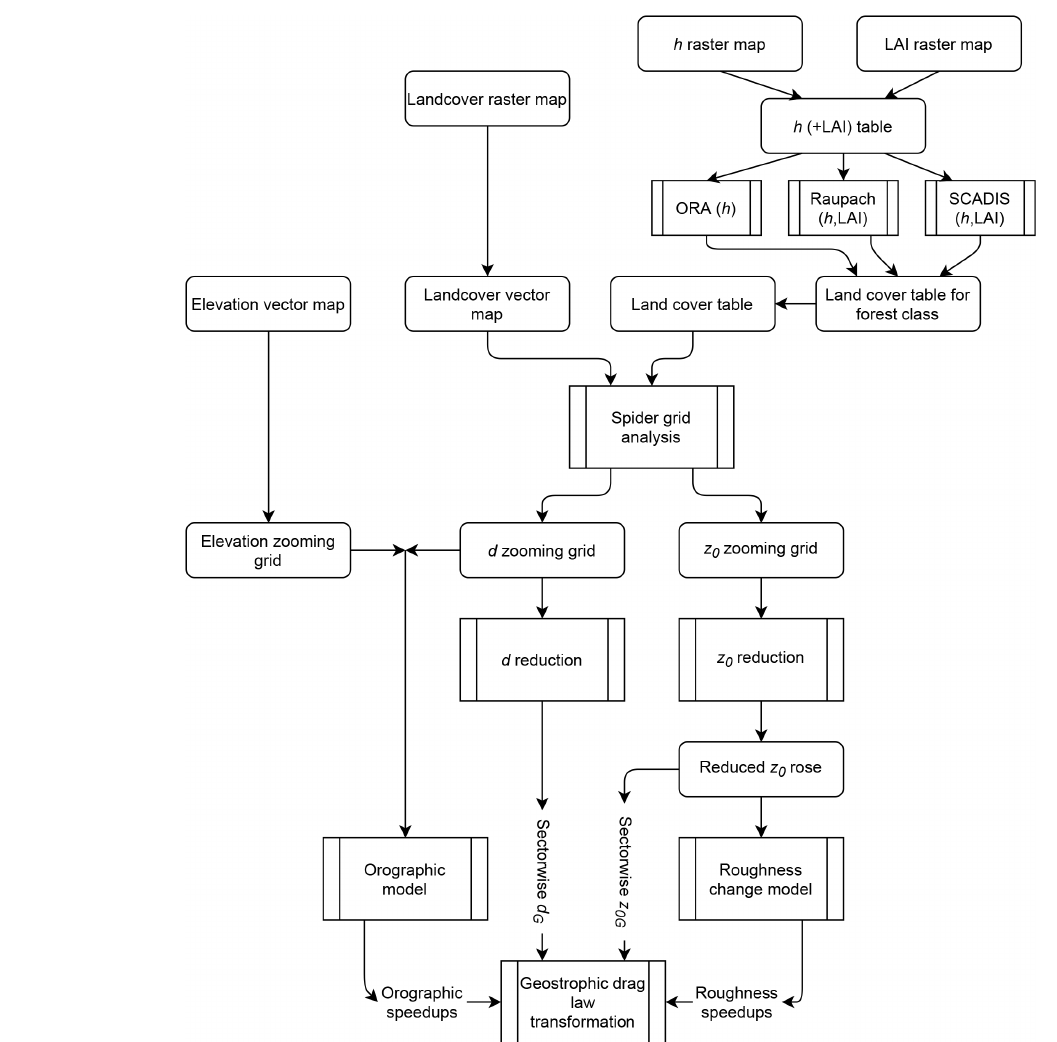
Figure 1. Process diagram of the submodels in WAsP. The rounded rectangles denote data structures, and the square boxes denote a method.